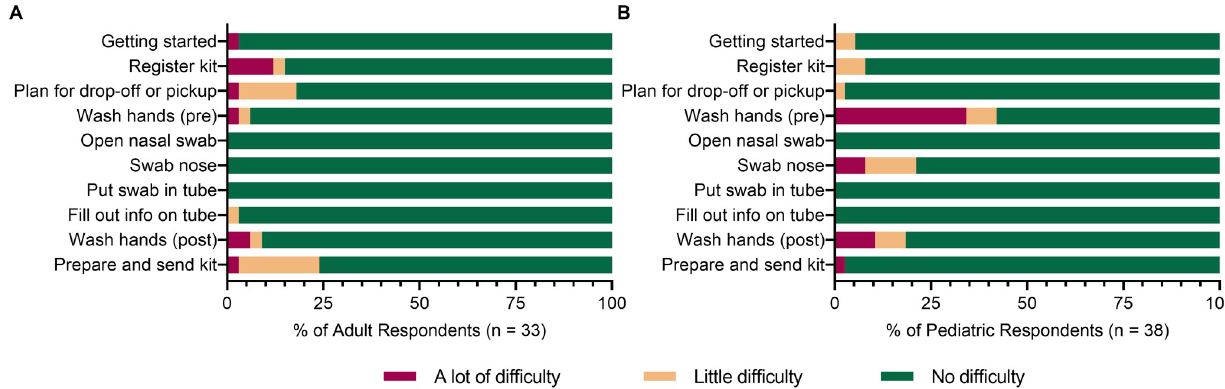
Fig 5. Usability studies demonstrate feasibility of at-home nasal specimen collection. Researcher’s assessment of observed difficulty for each step during (A) adult and (B) pediatric usability studies for at-home, nasal specimen self-collection using the HealthPulse@home COVID-19 Specimen Collection Kit.